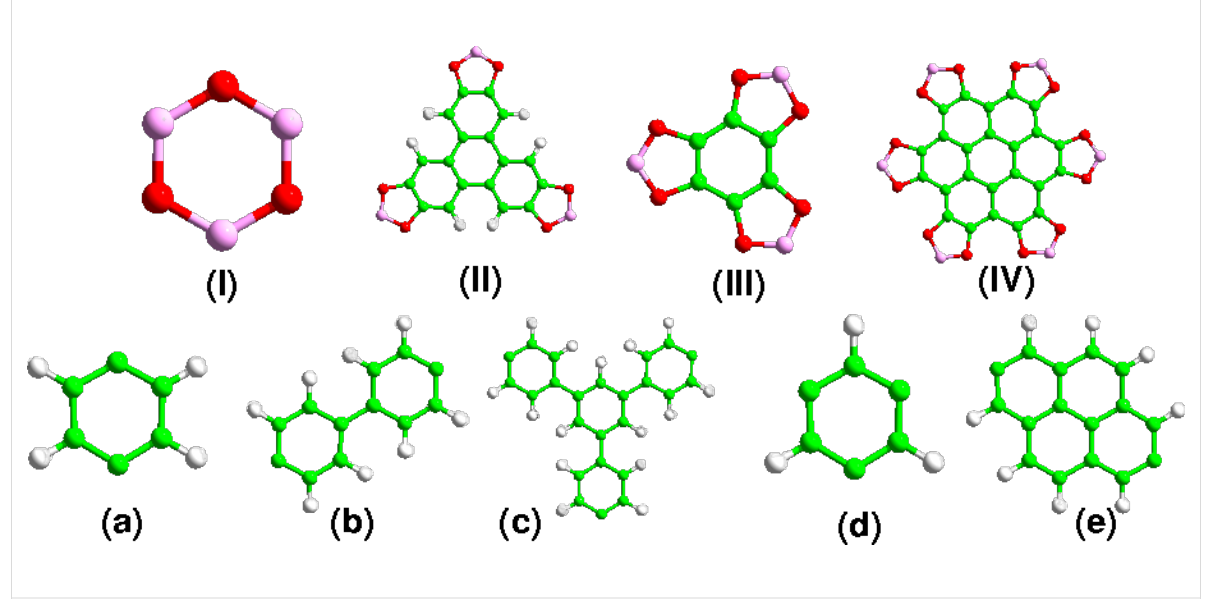
Figure 1: The connector ( I – IV ) and linker ( a – e ) units considered in this work. The same nomenclature is used in the text. Carbon – green; oxygen – red; boron – magenta; hydrogen – white.